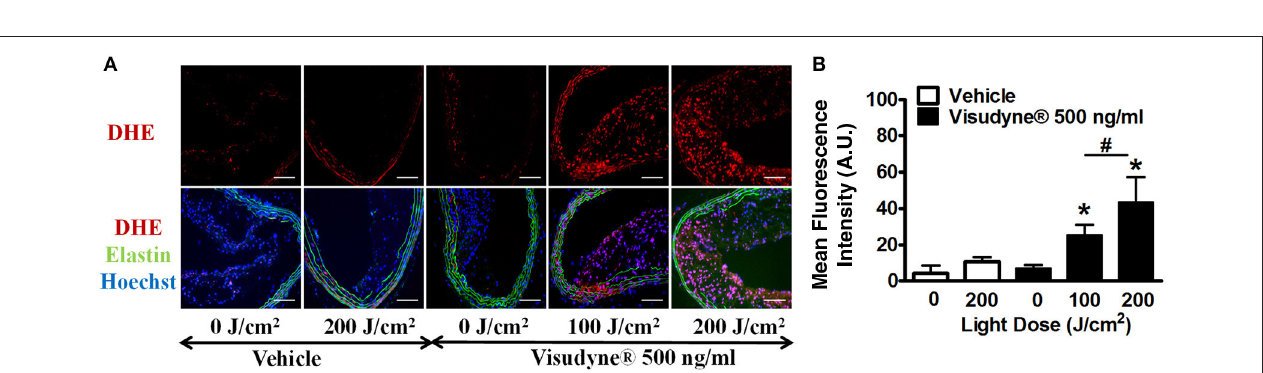
FIGURE 4 | Time dependent Visudyne ® uptake. Aorta isolated from ApoE − / − mice were treated with Visudyne ® (500 ng/ml) at different time intervals. (A) Representative sections demonstrating Visudyne ® accumulation at 5 ( n = 4), 10 ( n = 4), 15 ( n = 8) and 30min ( n = 4). Scale bar: 50 µ m. (B) Bar graph representing the mean fluorescence intensity after 5–30min of treatment. * P < 0.001 vs. 5min, # p < 0.001 5 vs. 10min, $ p < 0.001 10min vs. 15min.